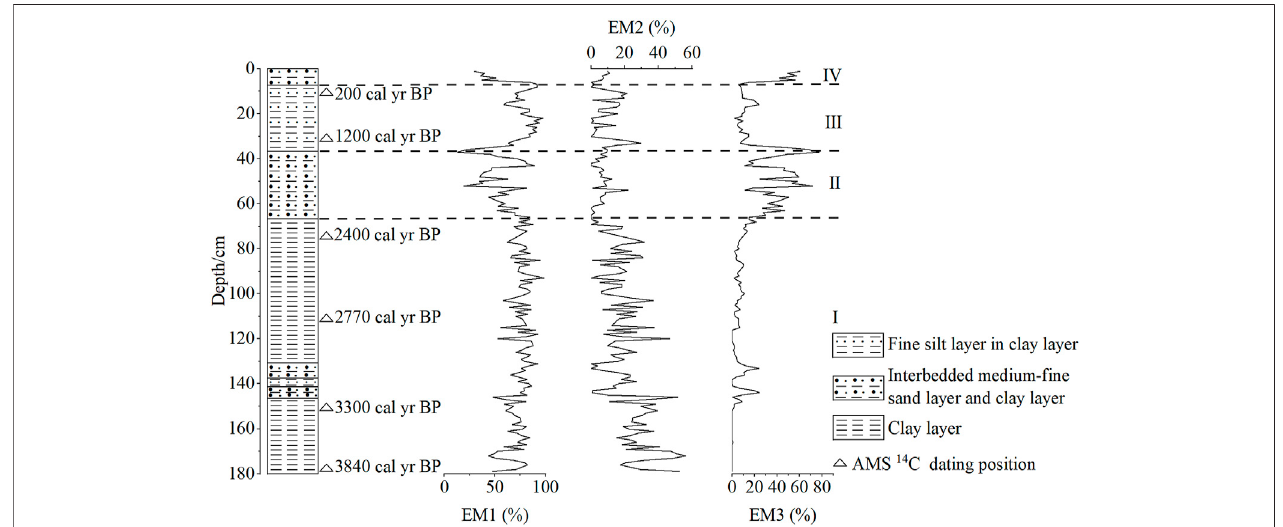
FIGURE 5 | SL-4 core variation in the % abundance of all three modeled